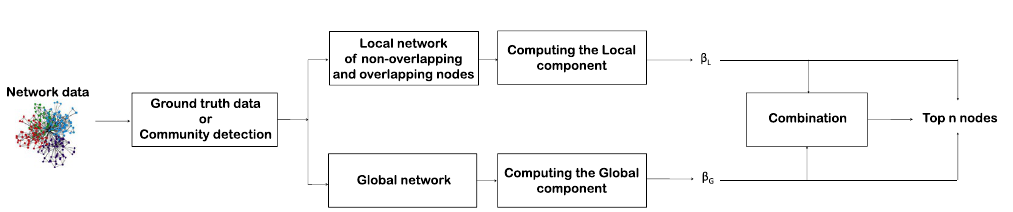
Figure 2. The main steps of the proposed ranking